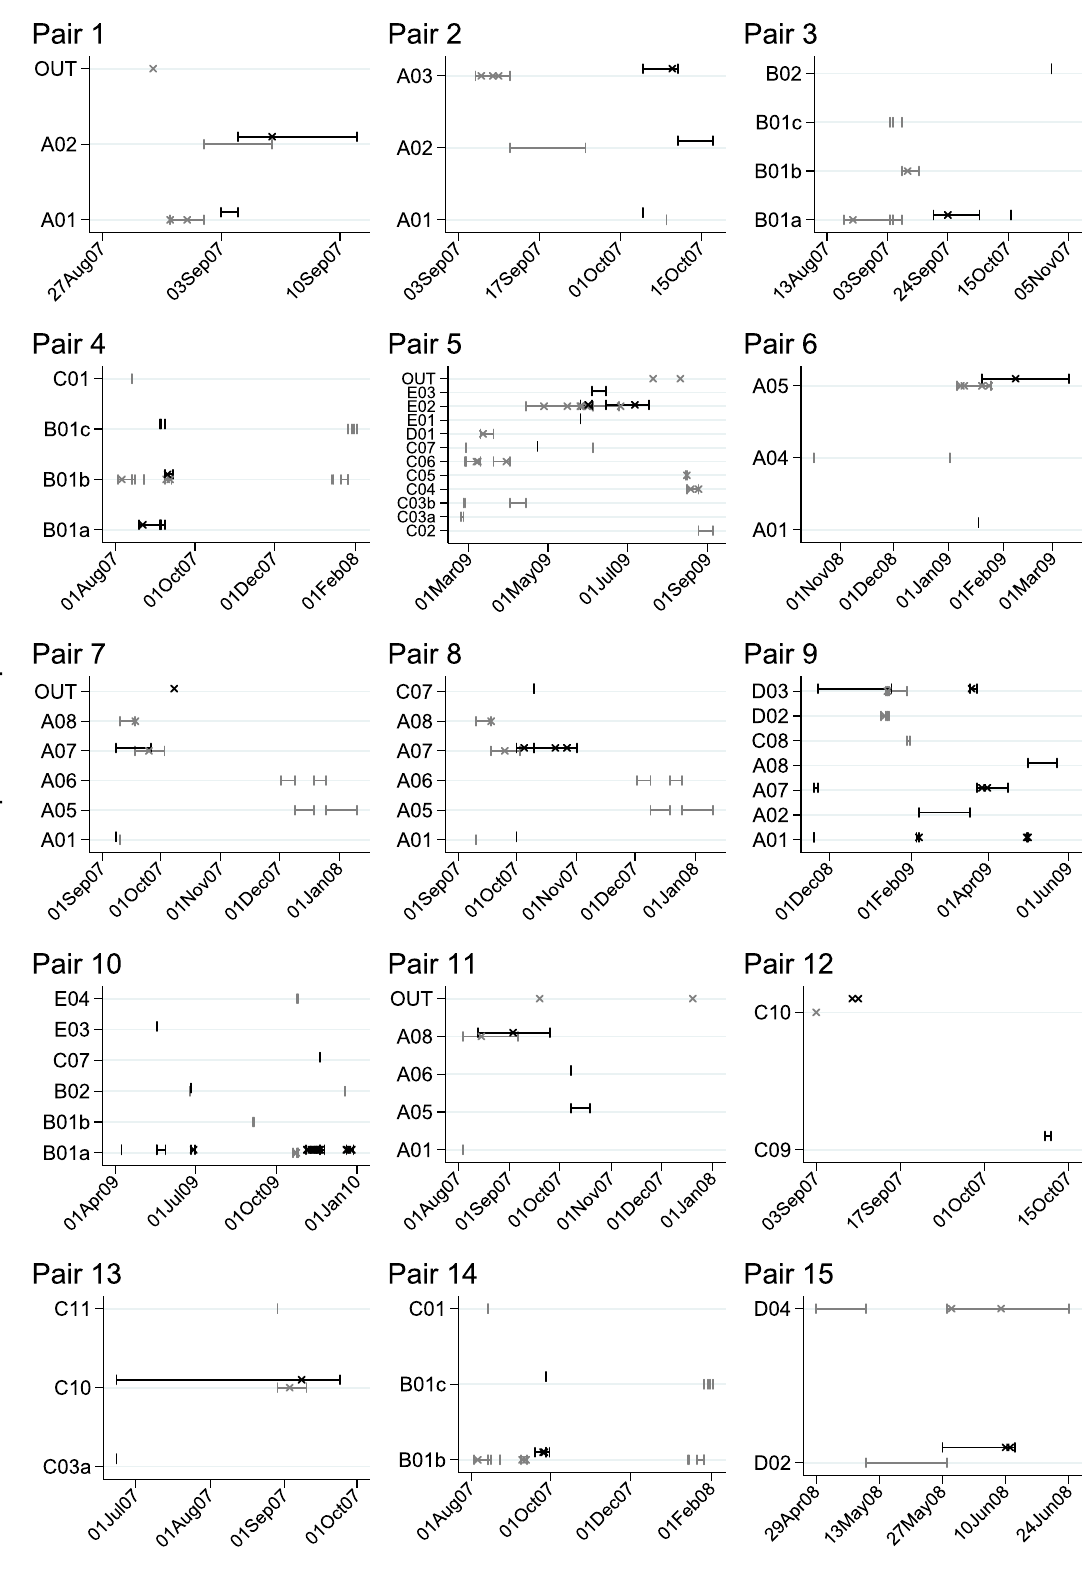
Figure 1. Epidemiological relationships between 15 potential donors and recipients of mixed infection transmission. Potential donors are shown in grey, and potential recipients in black. Time on a hospital ward around the time of diagnosis is shown as a horizontal line bounded by